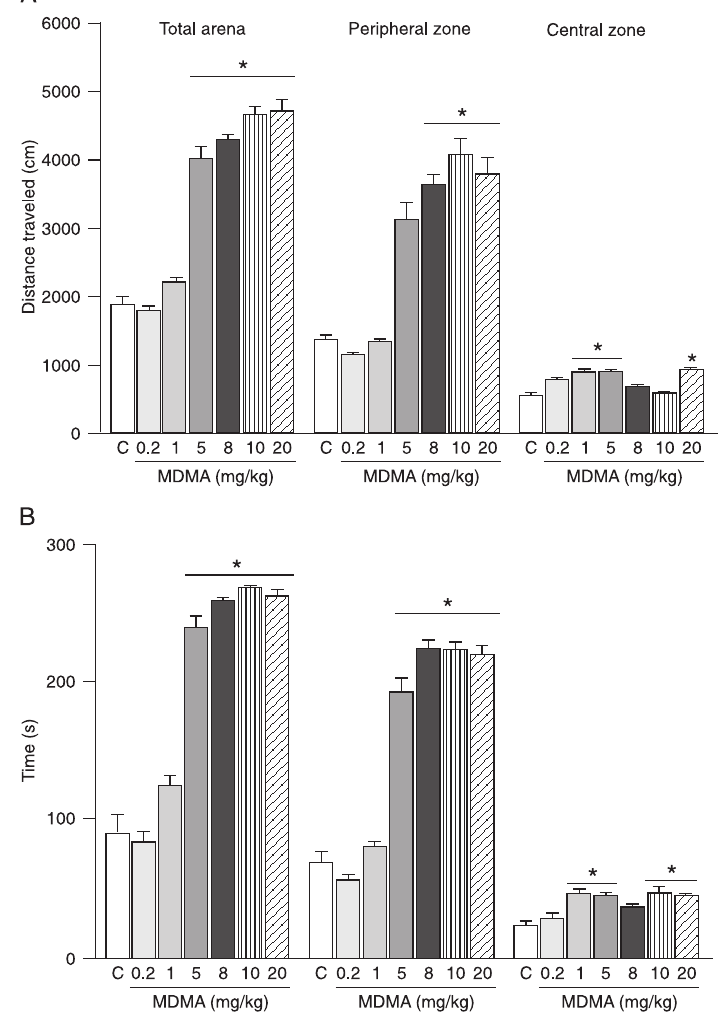
Figure 1. Behavioral effects of 3,4-methylenedioxymethamphetamine (MDMA) on BALB/c male mice in the open-field test. A , Distance traveled and B , time spent in movement during the 5 min of the test (total arena, peripheral and cen- tral zones). Data are reported as means ± SEM for 7-8 animals/group. *P < 0.05 compared to control (one-way ANOVA followed by Dunnett’s multiple compari- son test or Kruskal-Wallis test followed by Dunn’s multiple comparison